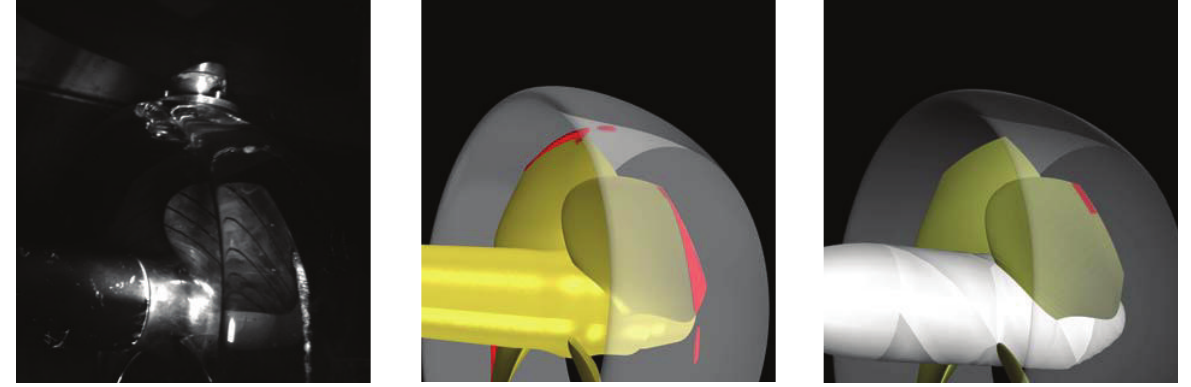
Figure 14: Observed and predicted (RANS and panel method) cavity extension at the design point.